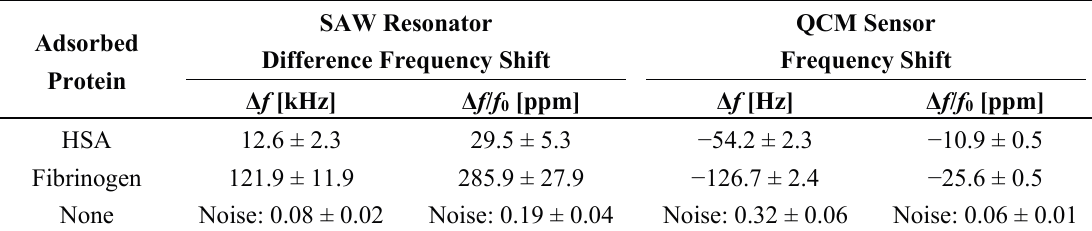
Table 2. Frequency shifts Δ f obtained by adsorption of HSA and fibrinogen, c = 250 µg/mL, in PBS on parylene C coated SAW resonators ( f 0 = 426.4 MHz) and QCM sensors ( f 0 = 4.95 MHz). Each protein was tested three times using a separate sensor for each experiment. The noise amplitudes were determined in the respective time interval prior to fibrinogen